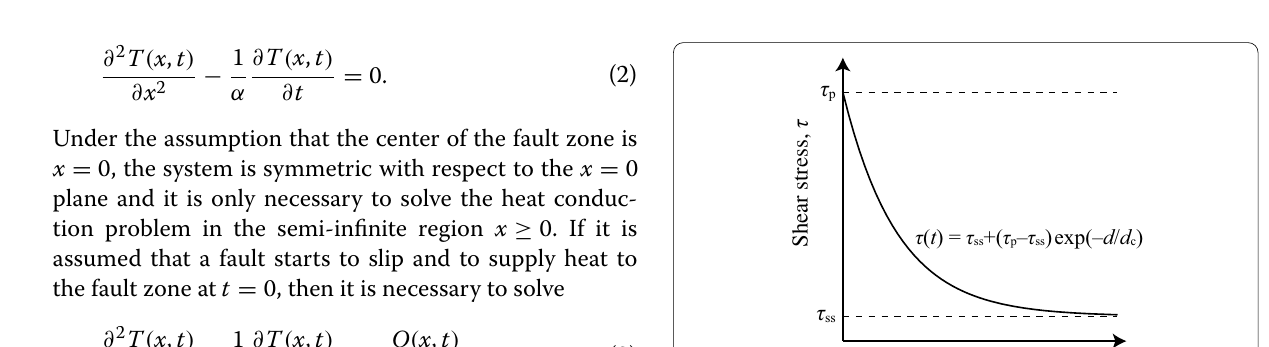
Fig. 1 The system discussed in this study. Before the onset of slip ( t < 0 ), there is no heat flow. During slip ( 0 deforms homogeneously at constant slip rate v s under time-dependent shear stress τ( t ) to supply heat to the fault zone, which generates heat flow parallel to the x direction. After slip ceases ( t s < t ), heat flow continues and contributes further to the temperature change